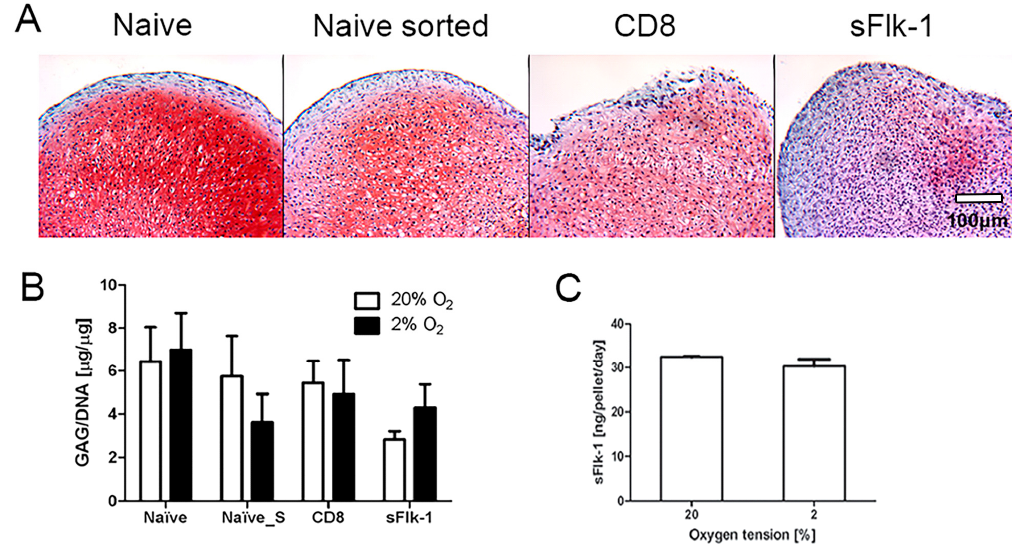
Figure 2. In vitro chondrogenesis of nasal chondrocytes. ( A ) Representative Safranin-O staining images of NC cultured in pellets at 20% of oxygen tension. Naïve, naïve mock-sorted (Naïve sorted), CD8 (control), and sFlk-1-releasing NC were cultured in vitro in pellets and analyzed for their chondrogenic potential. ( B ) Glycosaminoglycan (GAG) content of pellets generated by NC cultured at either 2% or 20% of oxygen tension (2 donors, n = 9). ( C ) Amount of mouse sFlk-1 released by sFlk-1-expressing NC-based pellets cultured at different oxygen tensions (2 donors, n = 4). No statistical significant difference has been found.